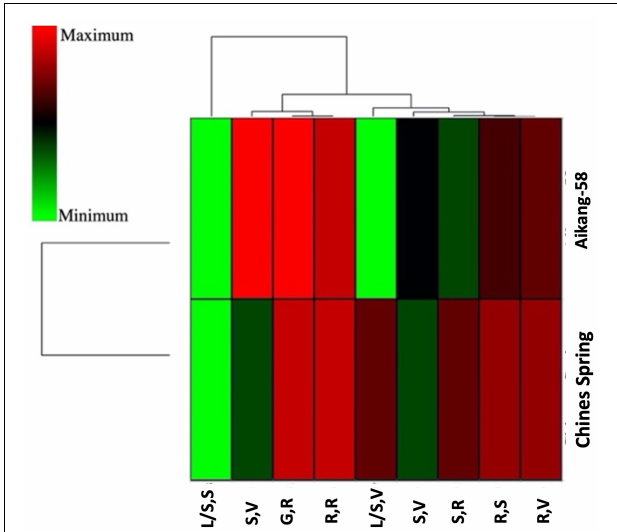
XLSTAT was used to create a heatmap. R,S: root seedling; R,V: roots at the vegetative growth phase; R,R: roots at the reproductive phase; L/S,S: leaves/shoot seedling; L/S,V: leaves/shoot, vegetative; S,V: spikes at the vegetative growth phase; SR: spikes at the reproductive phase; GR: grains at the reproductive